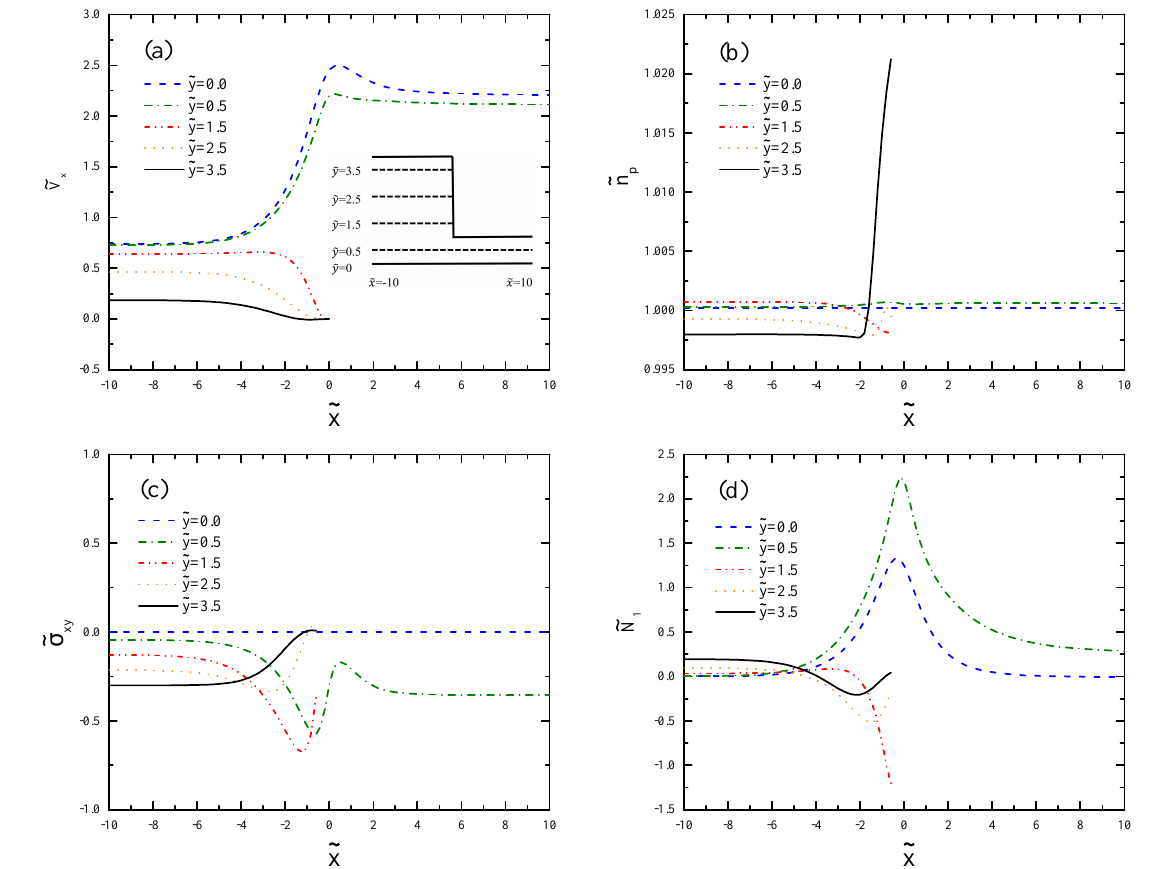
Figure 12. Cross-sectional profiles of ( a ) axial velocity, ( b ) polymer number density, ( c ) shear stress, and ( d ) first normal stress difference for De = 2.0. The selected ˜y-values are the same as in Figure